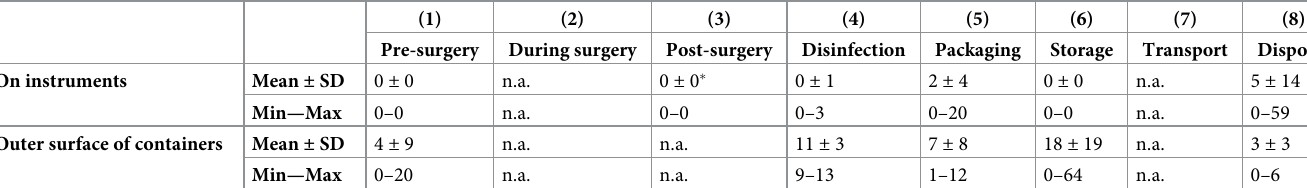
Table 1. Microbial load measured on instruments and the outer surface of reusable